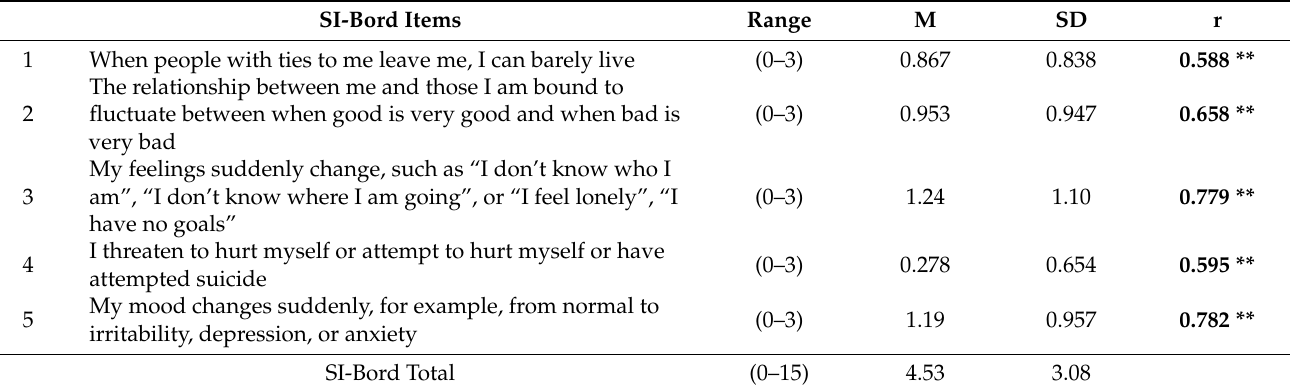
Table 1. Mean (M) and standard deviation (SD) of each item of the SI-Bord (N = 151). SI-Bord Items Range M